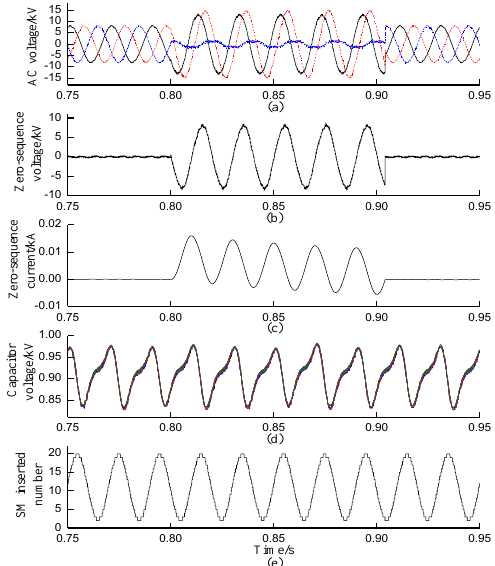
Figure 10. Fault response characteristics of MMC2 before optimization. ( a ) Three-phase AC voltage (blue is A-phase, black is B-phase, red is C-phase). ( b ) AC zero-sequence voltage. ( c ) AC zero-sequence current. ( d ) SM capacitor voltage. ( e ) Inserted SM number of the upper arm in phase A on the MMC2.